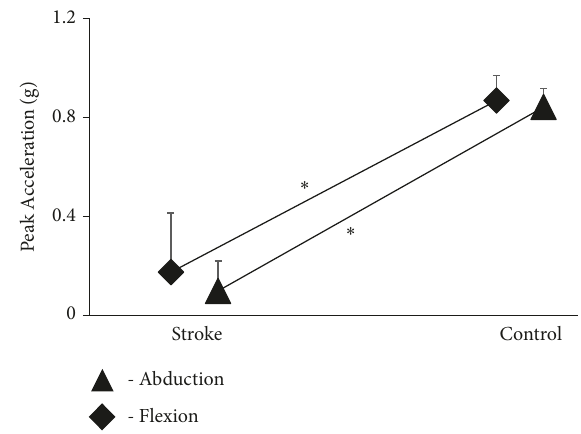
Figure 4: The data shows the impact of stroke on ipsilesional upper extremity in performance production outcomes on a) peak acceleration (g) compared to their healthy counterparts (p < 0.05) for both flexion- and abduction-reaching